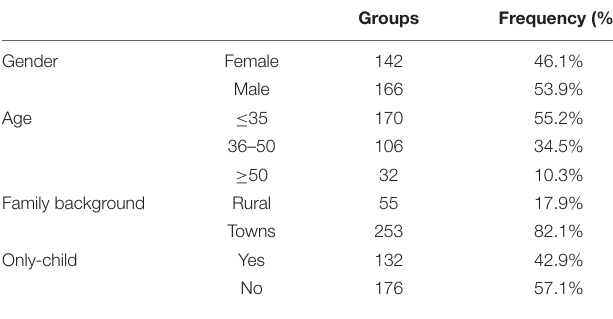
TABLE 1 | Socio-demographic characteristics of the participants ( n =